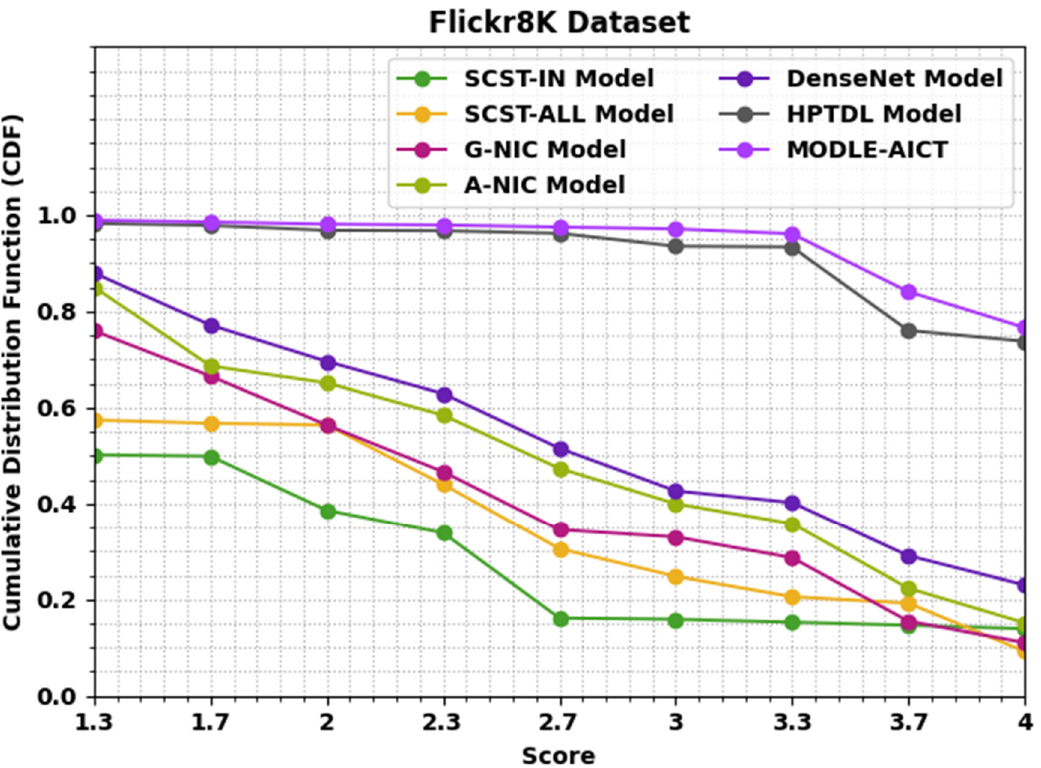
Figure 5. CDF analysis of MODLE-AICT technique with existing approaches on Flickr8K dataset.